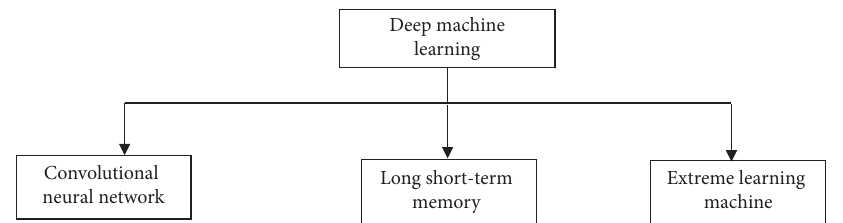
Figure 8: Subdivision of deep machine learning